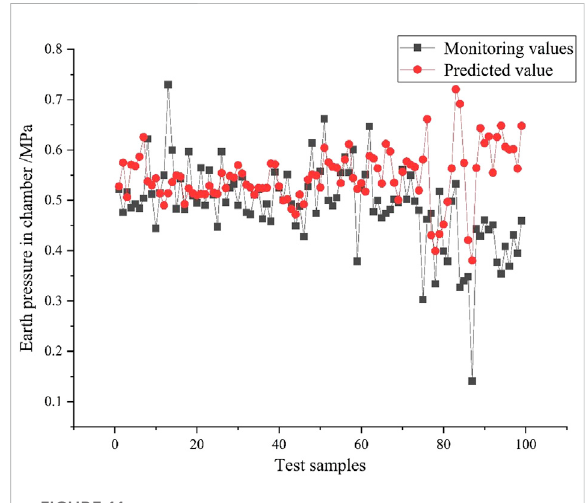
FIGURE 9 Comparison of prediction effects of different